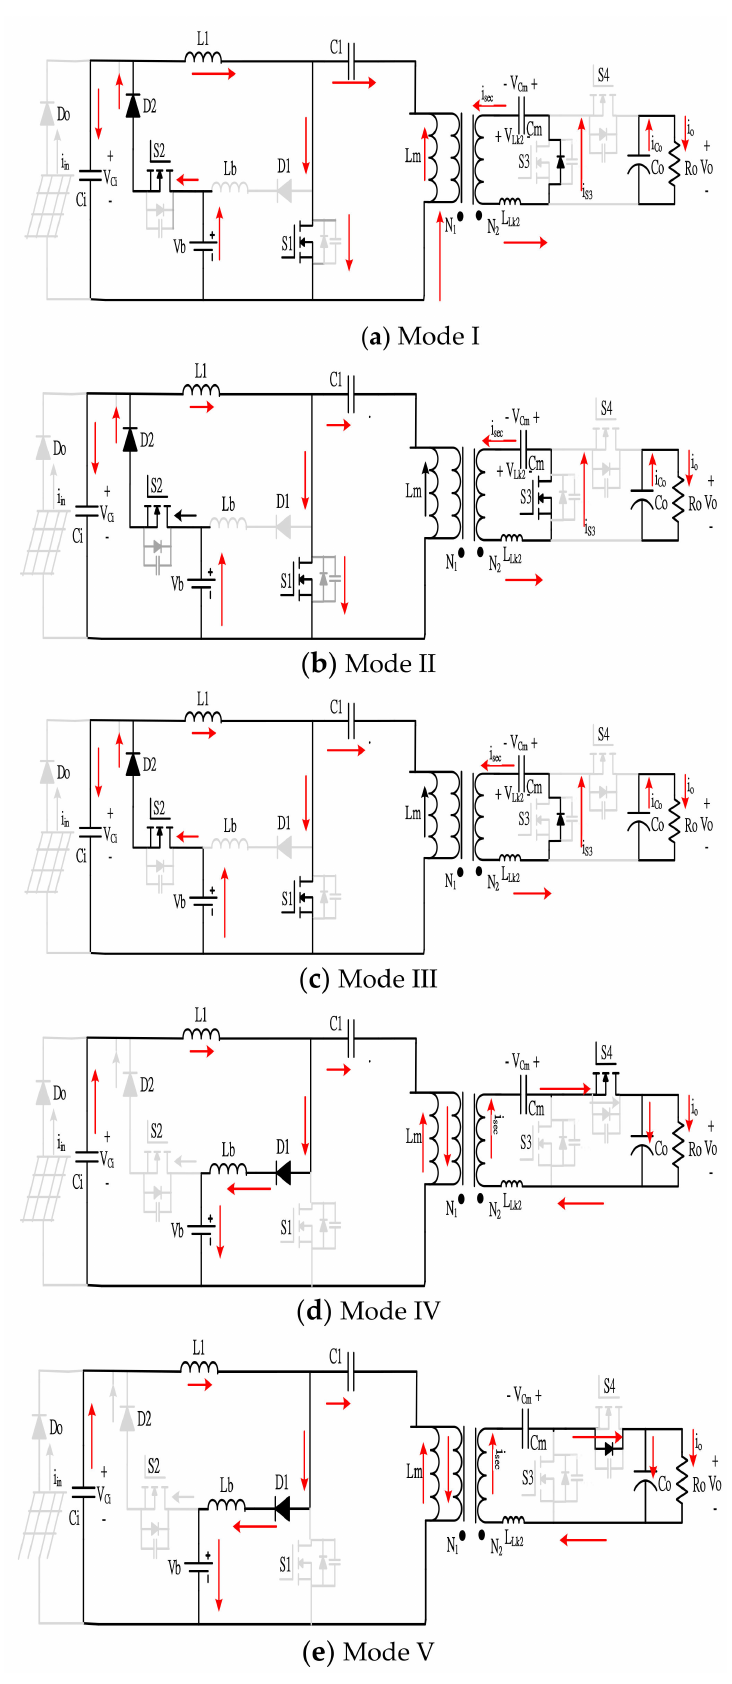
Figure 7. Operating diagram of each mode in Stage 2: ( a ) Mode I, ( b ) Mode II, ( c ) Mode III, ( d ) Mode IV, and ( e ) Mode